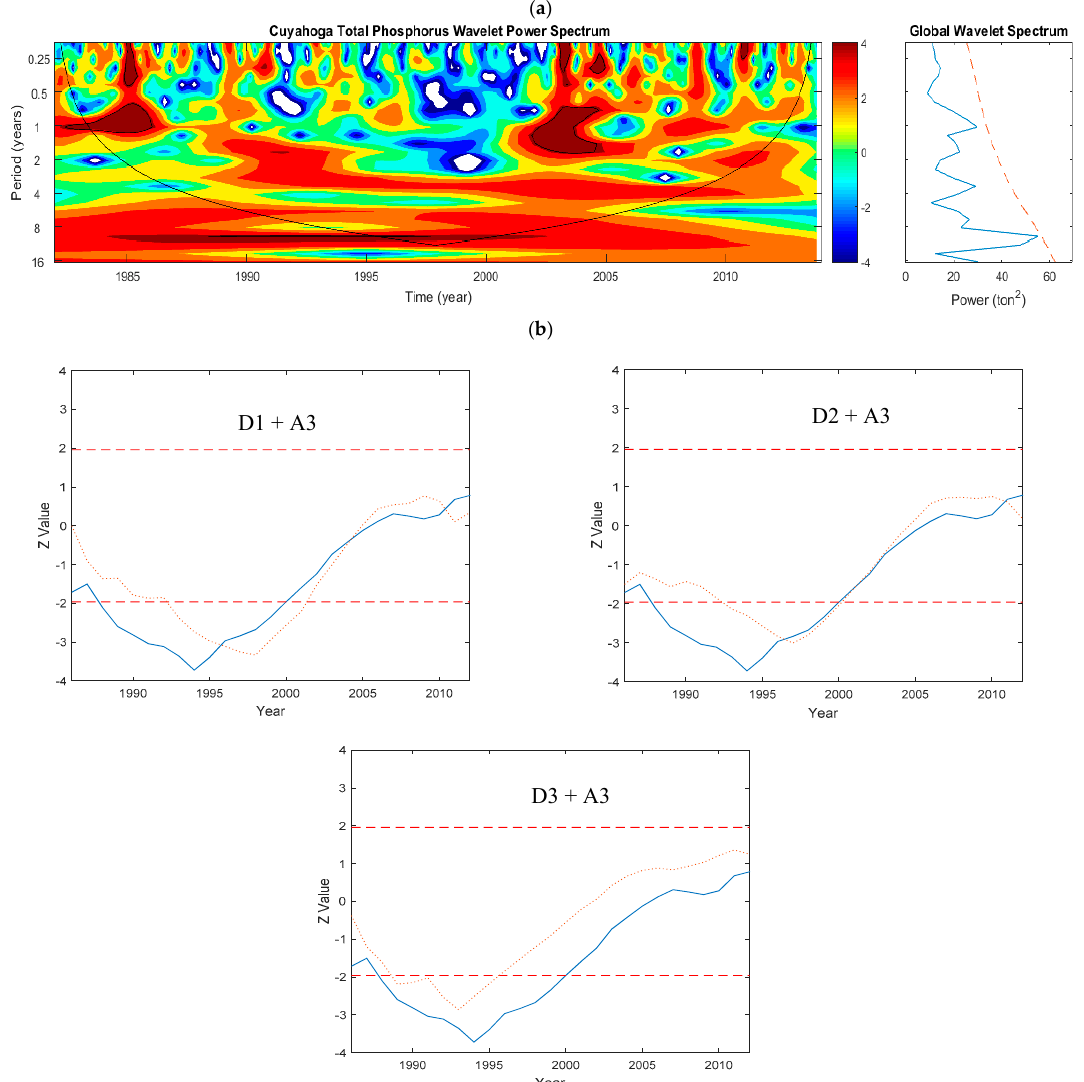
Figure 13. Cuyahoga River: ( a ) Continuous wavelet spectrum of daily total phosphorus (TP). ( b ) Plots of the sequential Mann–Kendall analyses on the Details (with added Approximation component) of the annual TP data. The top and bottom dashed lines are ±1.96, which are the confidence limits of the MK test using α = 5%. The solid and dotted lines show the sequential MK values for the original data and the Detail components, respectively. For this TP data, the D1 (2 years) and D2 (4 years) components were the most dominant periodicities for this trend.